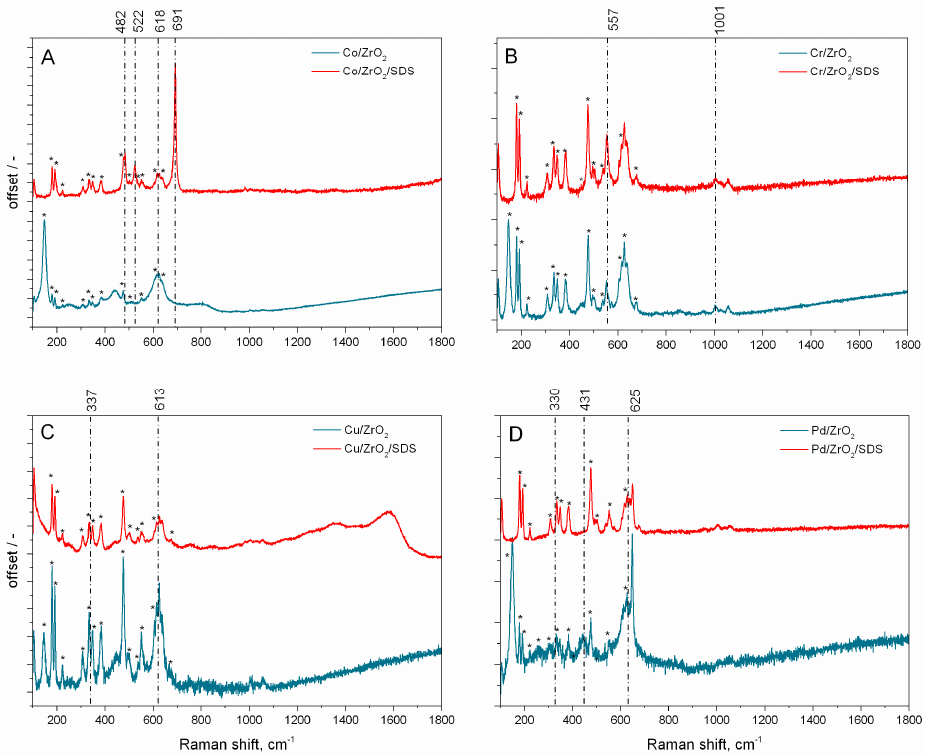
Figure 5. In situ µRaman analysis of sonically-prepared catalysts: ( A ) Co/ZrO 2 , Co/ZrO 2 /SDS; ( B ) Cr/ZrO 2 , Cr/ZrO 2 /SDS; ( C ) Cu/ZrO 2 , Cu/ZrO 2 /SDS; ( D ) Pd/ZrO 2 , Pd/ZrO 2 /SDS.